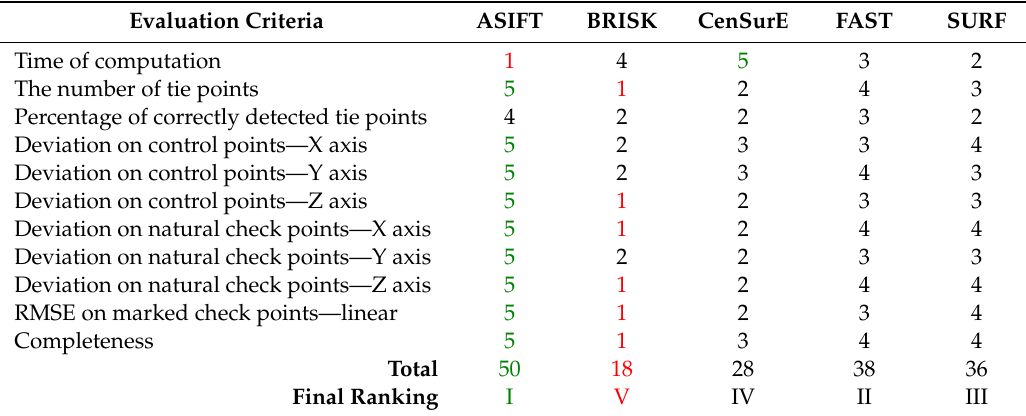
Table 7. Summary of evaluation of the usefulness criteria of point detection algorithms for all Test Sites according to the scale from 1 to 5 with the worst (red) and the best (green) results